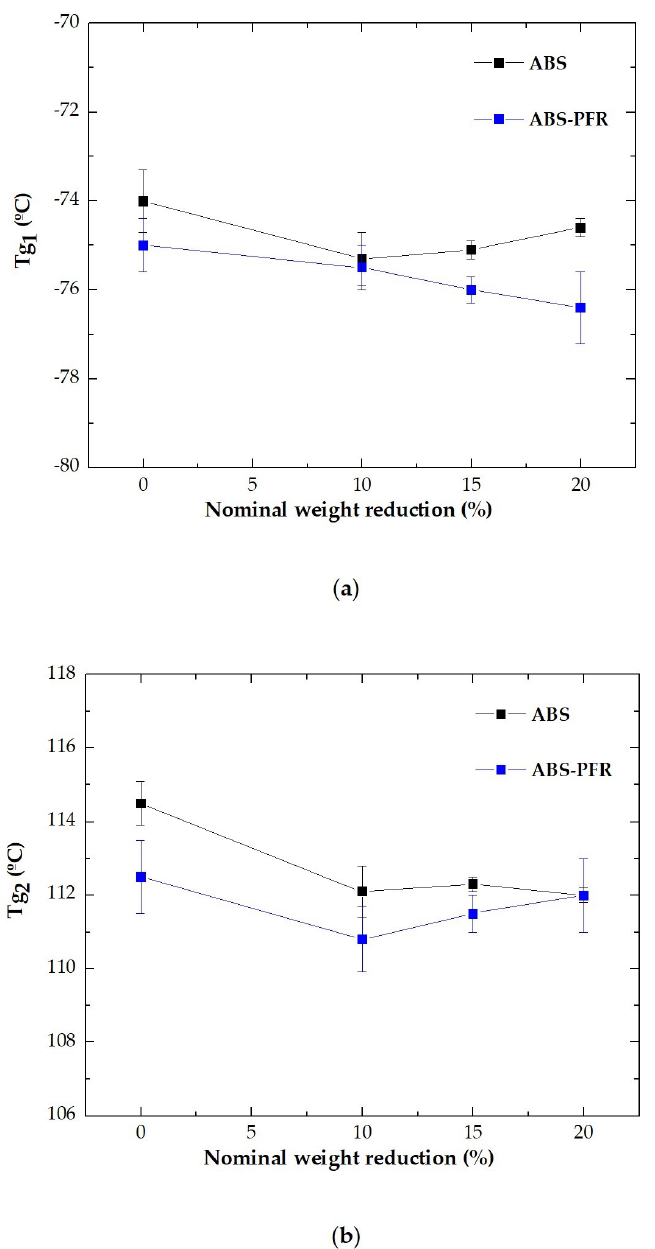
Figure 8. Variation of the glass transition of the ( a ) rubbery ( T g1 ) and ( b ) rigid ( T g2 ) phases of ABS and ABS/PFR with the nominal weight